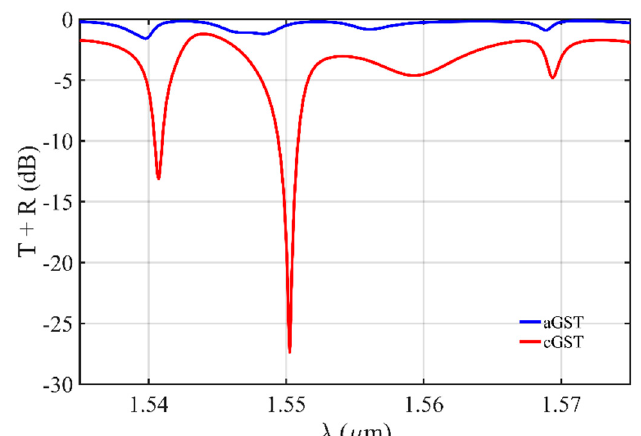
Figure 7. The sum of the transmittance of the output port and the reflectivity of the reflecting port in Sagnac optical buffer based on 1 × 3 MOMRs with GST.